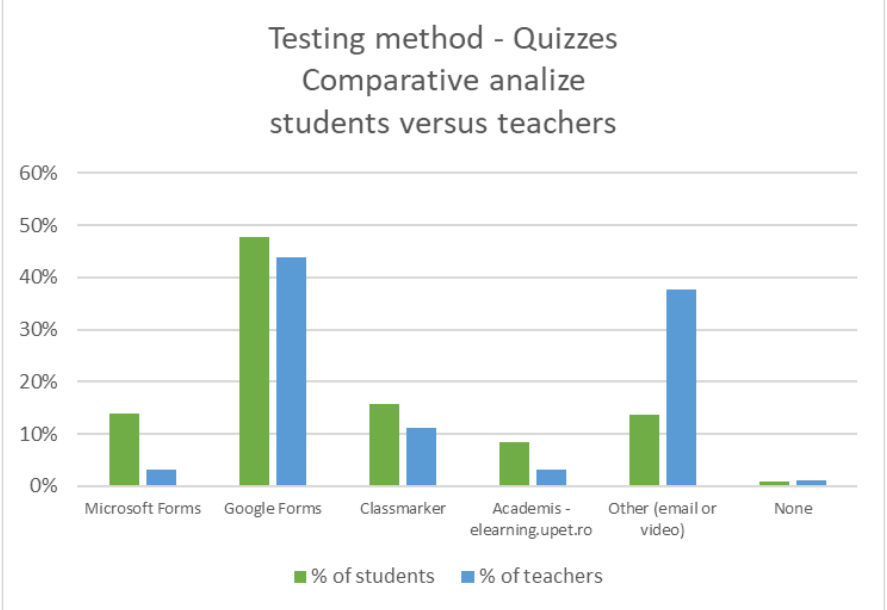
Figure 9. Different perception for homework transmission method used, teachers versus students.